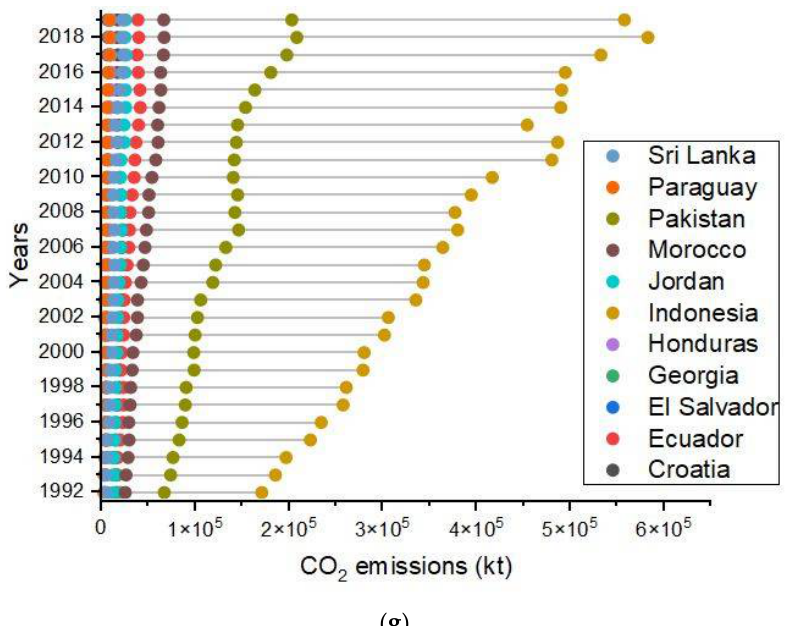
Figure 1. Temporal variations in ( a ) financial deepening, ( b ) FID, ( c ) FMD, ( d ) FDI, ( e ) GDP, ( f ) population, and ( g ) CO 2 e for G-11 countries during 1990–2019.